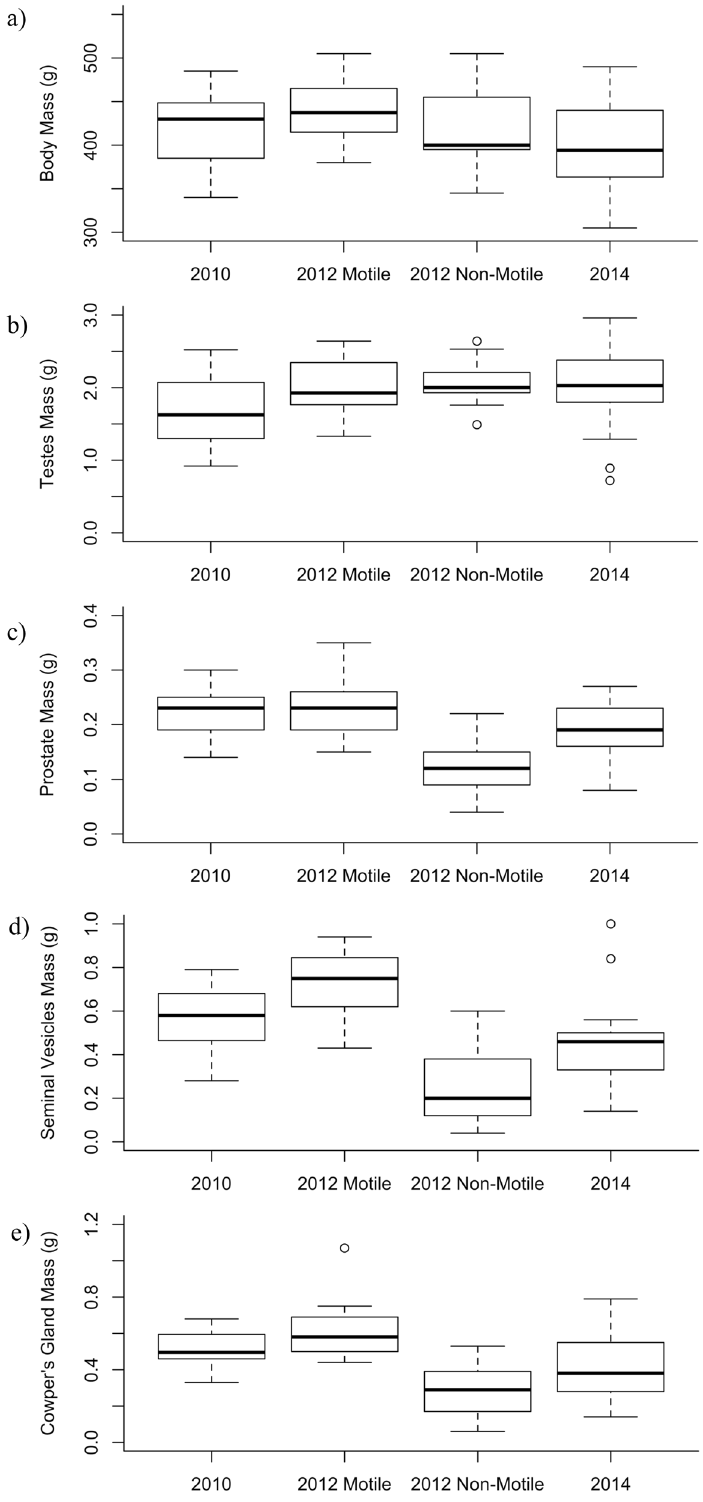
Figure 2. Male Richardson’s ground squirrels ( Urocitellus richardsonii ) at the Assiniboine Park Zoo in Winnipeg, Canada were analyzed for differences among years (2010, 2012, and 2014) and between those with motile sperm and those with non-motile sperm in 2012. We measured body mass ( a ), testes mass ( b ), prostate mass ( c ), seminal vesicles mass ( d ), Cowper’s gland mass ( e